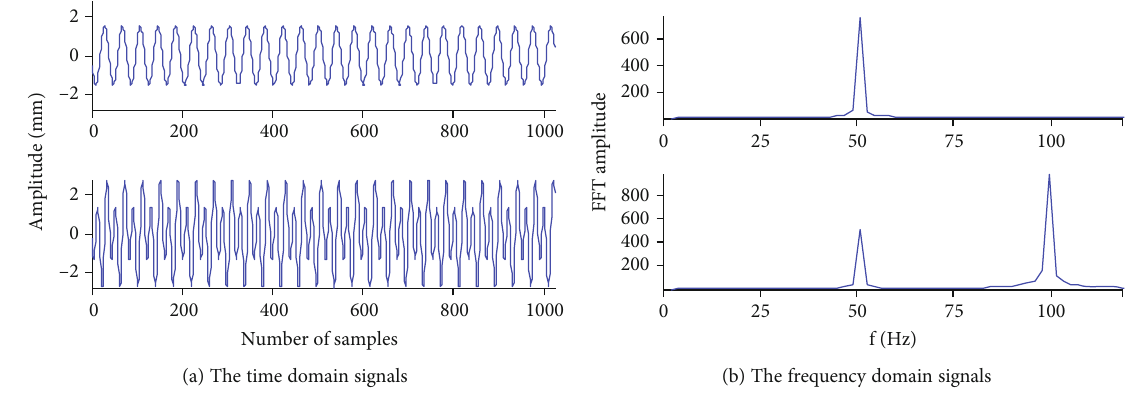
Figure 1: The time – frequency waveform of source